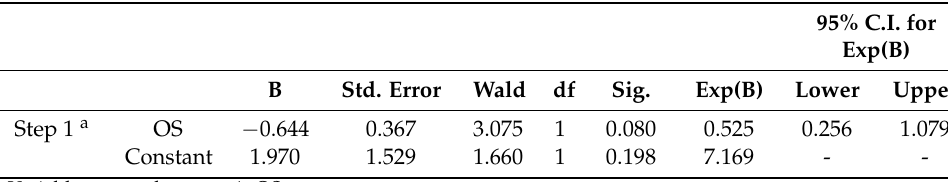
Table 20. Organisation size: regression analysis for public cloud.